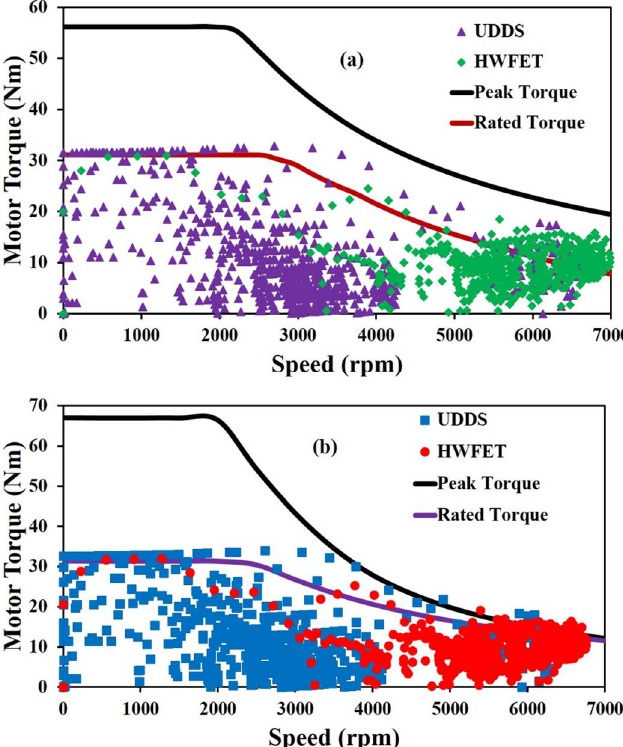
Figure 14. Torque distribution profiles for ( a ) IPMSMs and ( b ) PMa-SynRMs over the driving cycles.